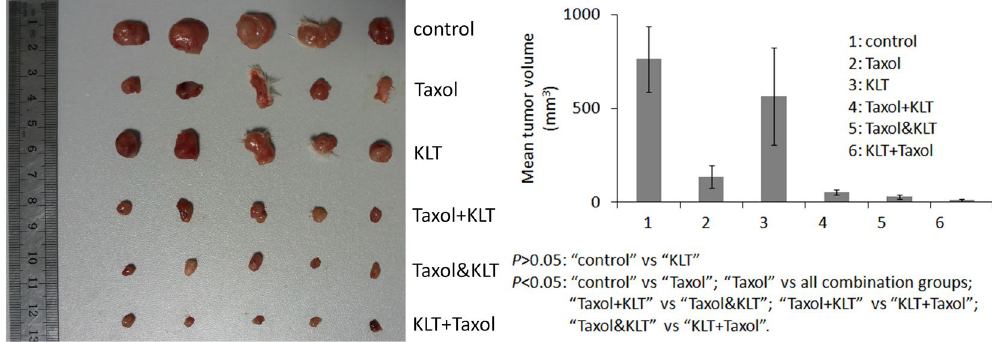
Figure 6. Synergistic inhibition of tumour growth by KLT and Taxol. Five mice were used in each group. Treatment concentrations were 3 nM for Taxol and 10 µ g/ml for KLT. Tumours were allowed to develop for 15 days. Columns represent the mean from five tumours and bars represent standard deviations. Average tumour volumes in each group were compared by student’s t-test. P < 0.05 represents significant